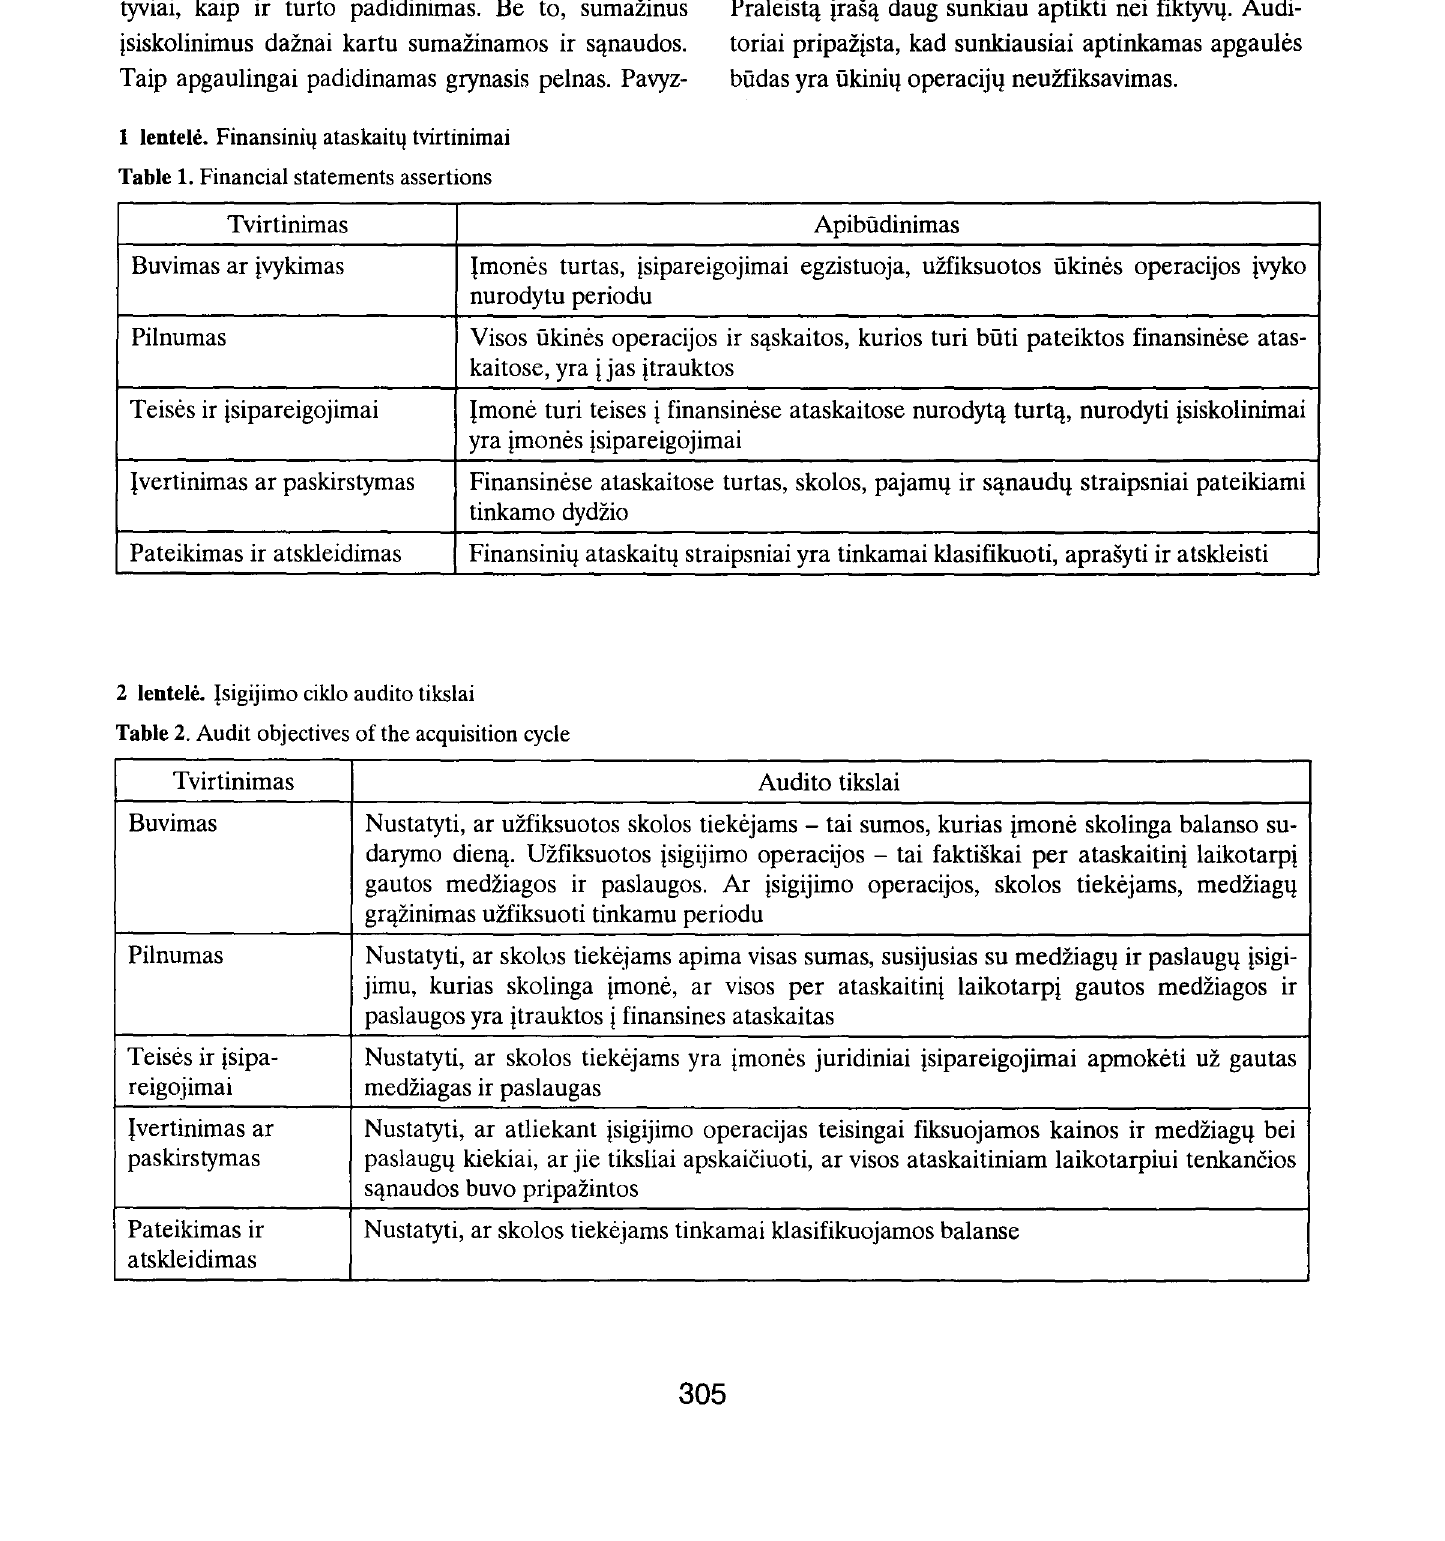
Table 1. Financial statements assertions